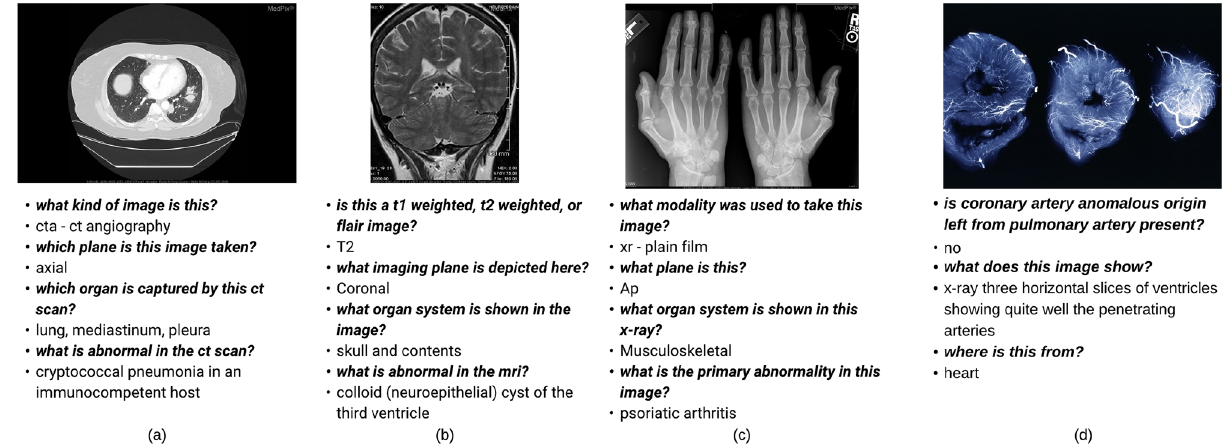
Figure 1. Sample radiology scans and the corresponding question-answer pairs from the MED-VQA and PathVQA dataset. The first three ( a – c ) belong to the MED-VQA dataset and the last one ( d ) belongs to the PathVQA